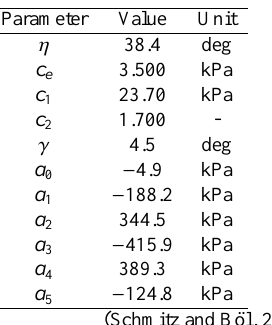
Table 3 Chemical parameters in enzyme reaction Eq.